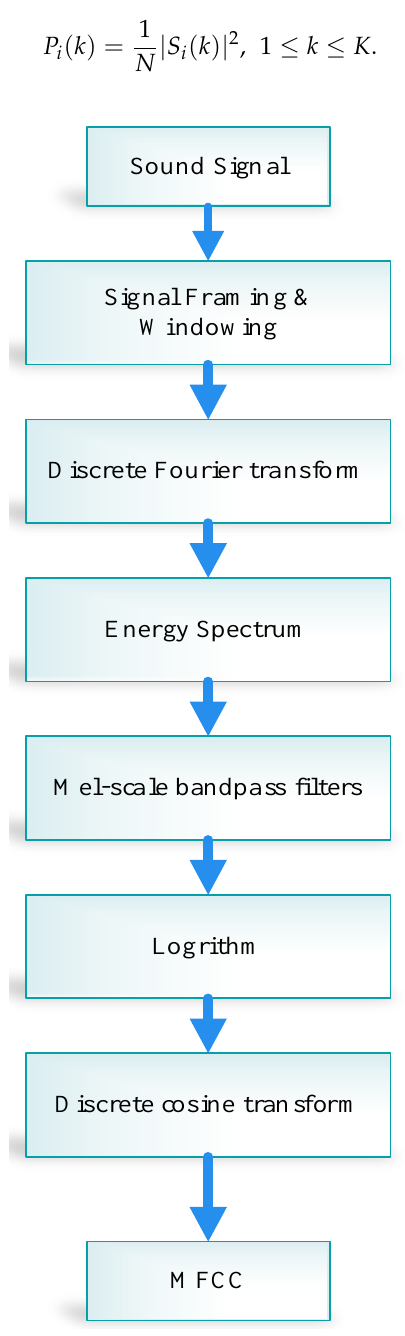
Figure 3. MFCC Feature Extraction Figure 3: MFCC Feature Extraction Pipeline